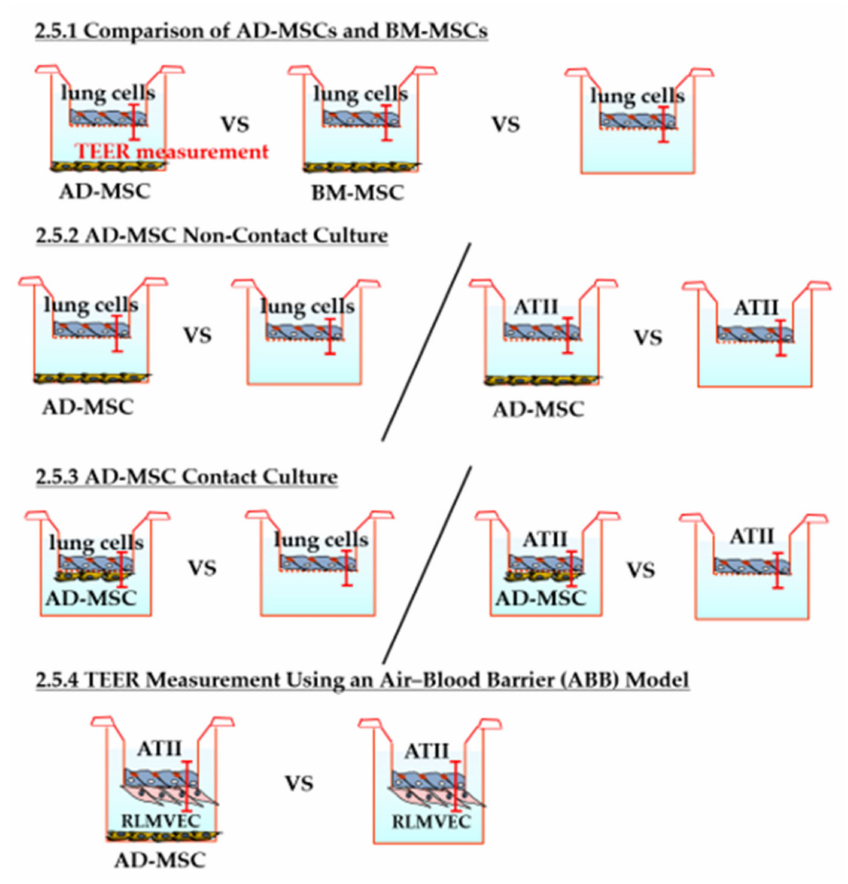
Figure 1. Schematic of the experiment design. TEER, transepithelial electrical resistance; AD-MSC, adipose-derived mesenchymal stem/stromal cell; BM-MSC, bone marrow-derived mesenchymal stem/stromal cell; ATII, alveolar epithelial type II; RLMVEC, rat lung microvascular endothelial